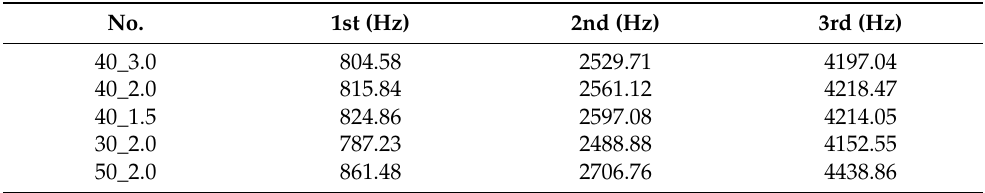
Table 4. First three order frequencies of the threaded specimens in the modal tests (source elaborated by